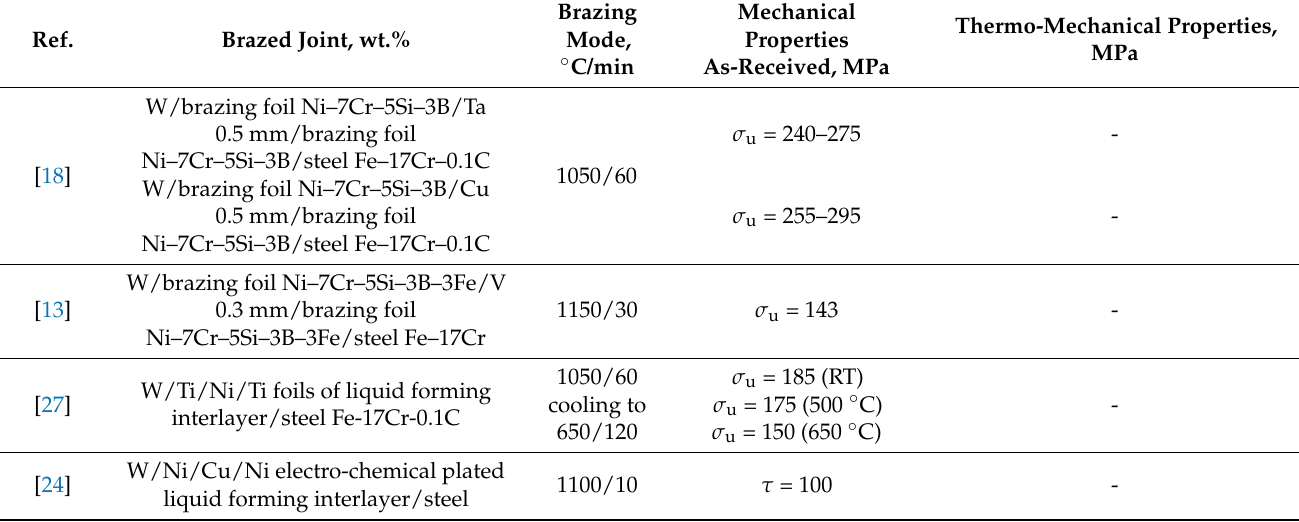
Table 1. The latest progress made in tungsten/steel brazing ( σ u —ultimate strength, τ —shear strength, “-”—no data, RT—Room